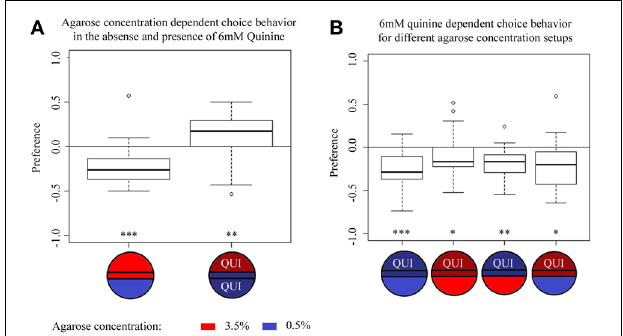
FIGURE 3 | Agarose- and quinine- dependent choice behavior tested in different contexts. (A) Agarose-dependent choice behavior for an agarose concentration of 0.5% over 3.5% without quinine (left box plot) or in the presence of 6mM quinine (right box plot). Without quinine, wild-type larvae avoid 3.5% agarose in favor of the 0.5% agarose side of the Petri dish ( p < 0 . 001). In the presence of 6mM quinine in the entire dish, the preference for the two agarose concentrations reversibly changes compared to the initial situation; now, wild-type larvae avoid 0.5% agarose in favor of 3.5% agarose ( p < 0 . 01). (B) Larval choice behavior for 6mM quinine over pure agarose tested on different agarose concentration setups. In general, irrespective of the tested combinations of agarose concentration, wild-type larvae significantly avoid 6mM quinine over pure agarose, i.e., on plates containing 0.5% agarose on both sides (first boxplot, p < 0 . 001), on plates containing 3.5% agarose on both sides (second boxplot, p < 0 . 05), on plates in which quinine was presented in 0.5% agarose vs. pure 3.5% agarose (third box-plot, p < 0 . 01), and on test plates in which quinine was presented in 3.5% agarose vs. pure 0.5% agarose (fourth box-plot, p < 0 . 05). Sample size n > 12 for each group. Small circles indicate outliers. ∗∗∗ p < 0 . 001; ∗∗ p < 0 . 01; ∗ p < 0 . 05.